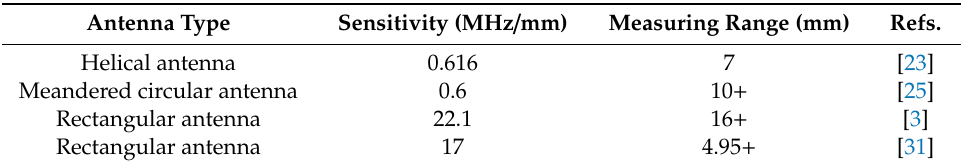
Table 3. Comparison of the performance of